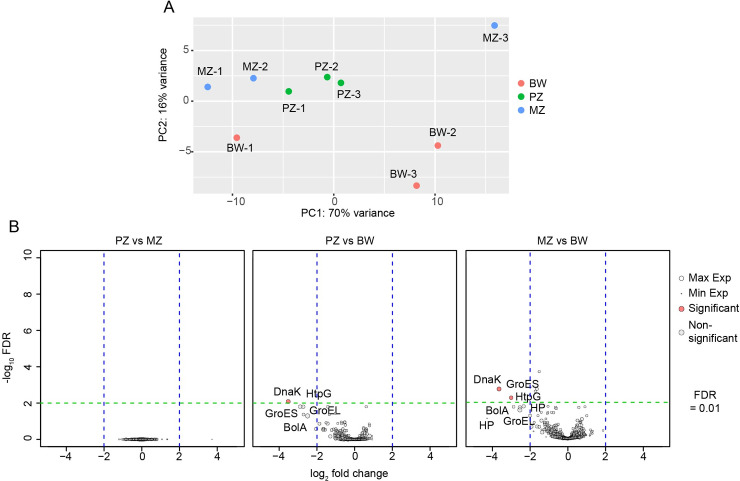
wBm gene expression levels in the B. malayi female germline and soma.(A) Principal component analysis of the 250 most variable Wolbachia wBm genes showing the distribution of the tissue-specific replicates. PZ: proliferative zone (green); MZ: meiotic zone (blue); BW: body wall (red). (B) Volcano plot representations of the wBm gene expression level variations between samples. PZ: proliferative zone; MZ: meiotic zone; BW: body wall. Y axis: -log10 (FDR); X axis: log2 (fold change). The dot size reflects the gene expression level, and red dots are genes whose expression level is considered to be variable between samples upon the following criteria: |log2(fold change)| > 2 with a FDR < 0.01.